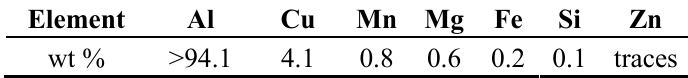
Table 1. Chemical composition of the Al 2017 powder